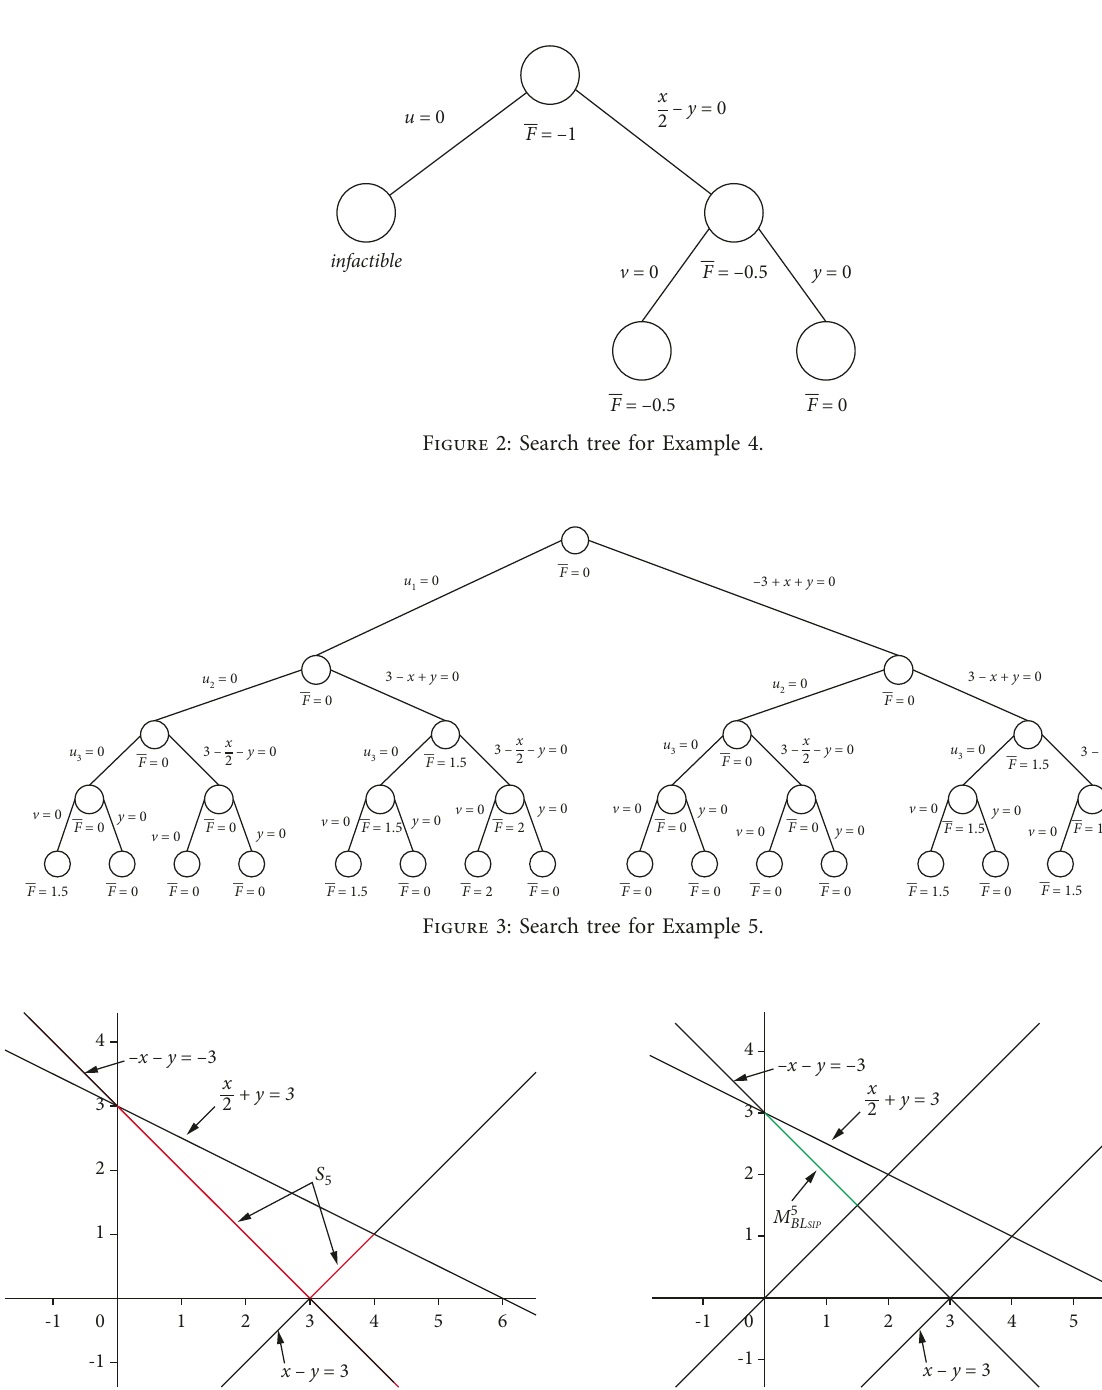
Figure 4: Solution graph of Q which results of P